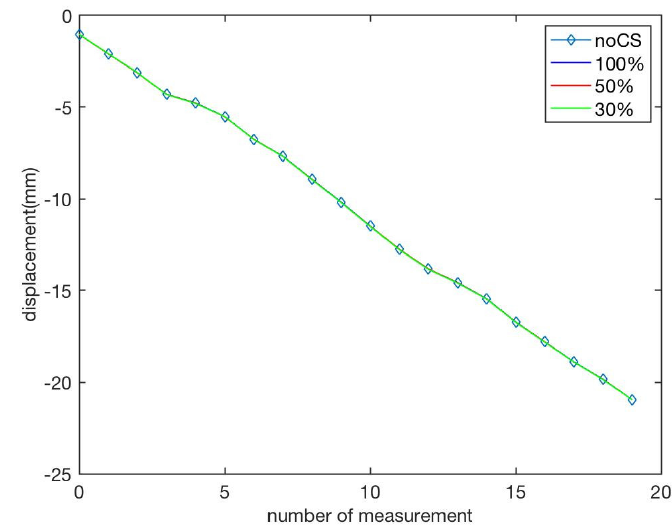
Figure 13. Cumulative measured displacement of the controlled metallic target at the test site “Campus”.